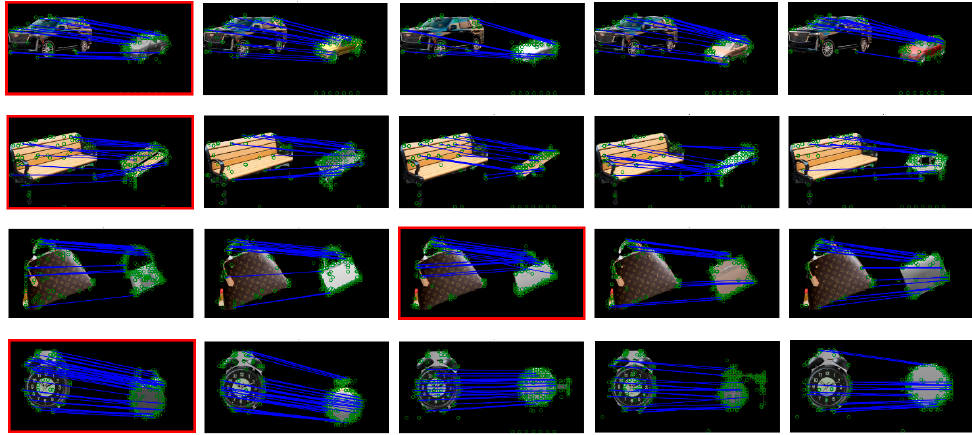
Figure 9. From the top, DELF feature matching results of CAR, Bench, Bag, and Clock. In each row, the leftmost CAD model is determined as the best similar object with the RGB